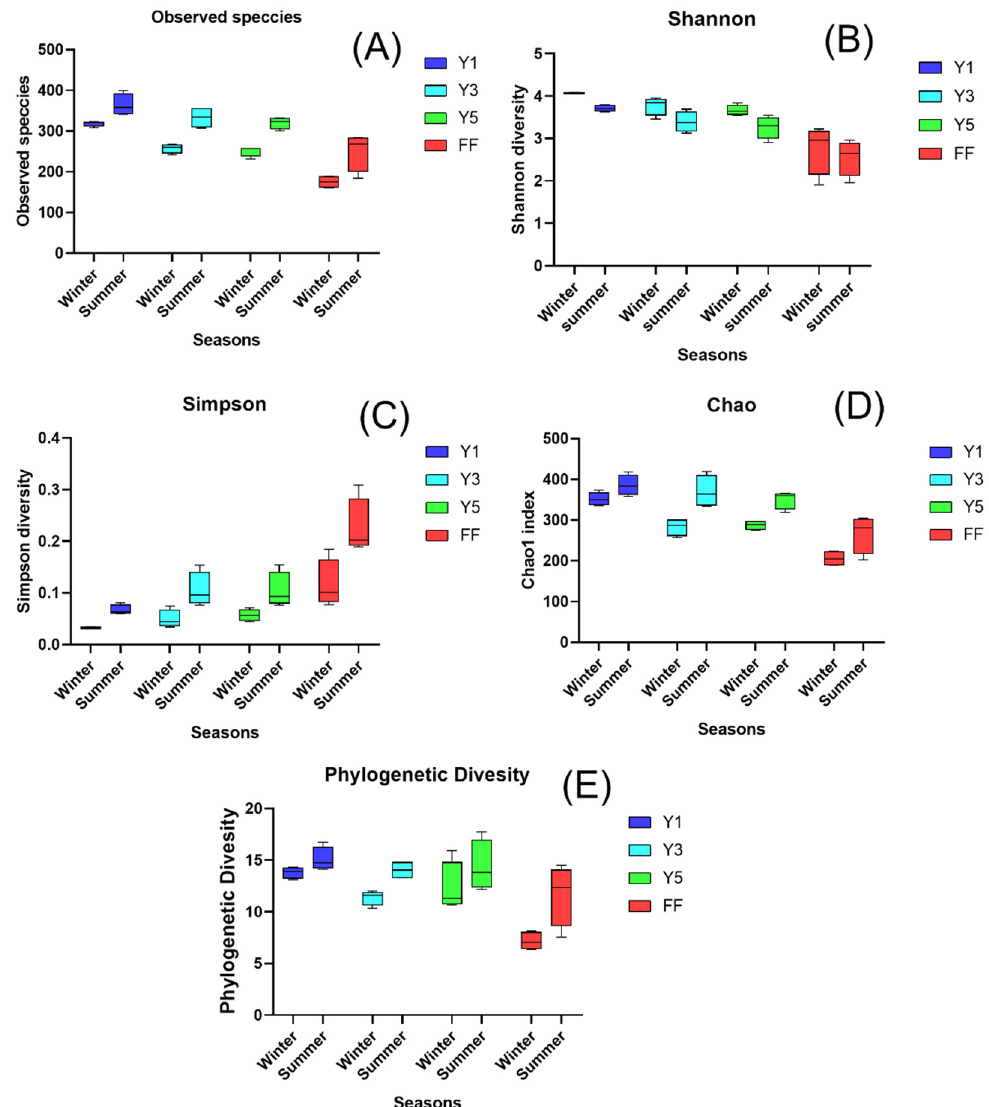
Figure 1. Alpha diversity indices of the fungal community in C. chinensis rhizosphere soils and fallow fields. Observed species richness ( A ), Shannon diversity index accounting for species abundance and evenness of distribution ( B ), Inverse Simpson diversity ( C ), Chao that estimates the actual species richness of sample ( D ), and the phylogenetic diversity ( E ) of FF, that is, the fallow field soil, where Y1 represents when one-year C. chinensis cultivated the soil, Y3 where three-year C. chinensis cultivated the soil, and Y5 indicates that five-year C. chinensis cultivated the soil. There were four independent replicates of each treatment.